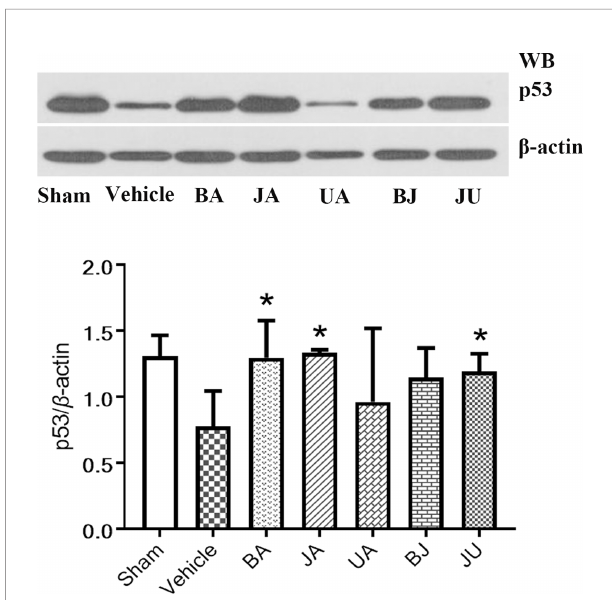
FIGURE 6 | Active patterns of p53 under different treatment conditions. Western blot analysis was employed to identify the regulation of p53 among different treatment groups. Differences were determined using single-tail test. *P < 0.05 vs.